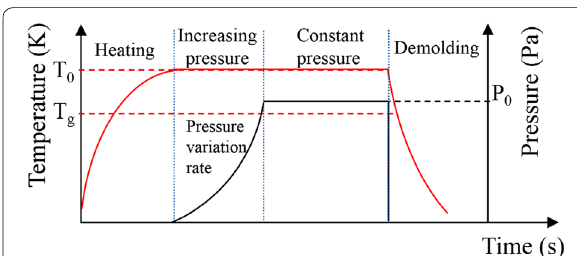
Fig. 3 Procedure of NIL experiments and simulations with the pres‑ sure and